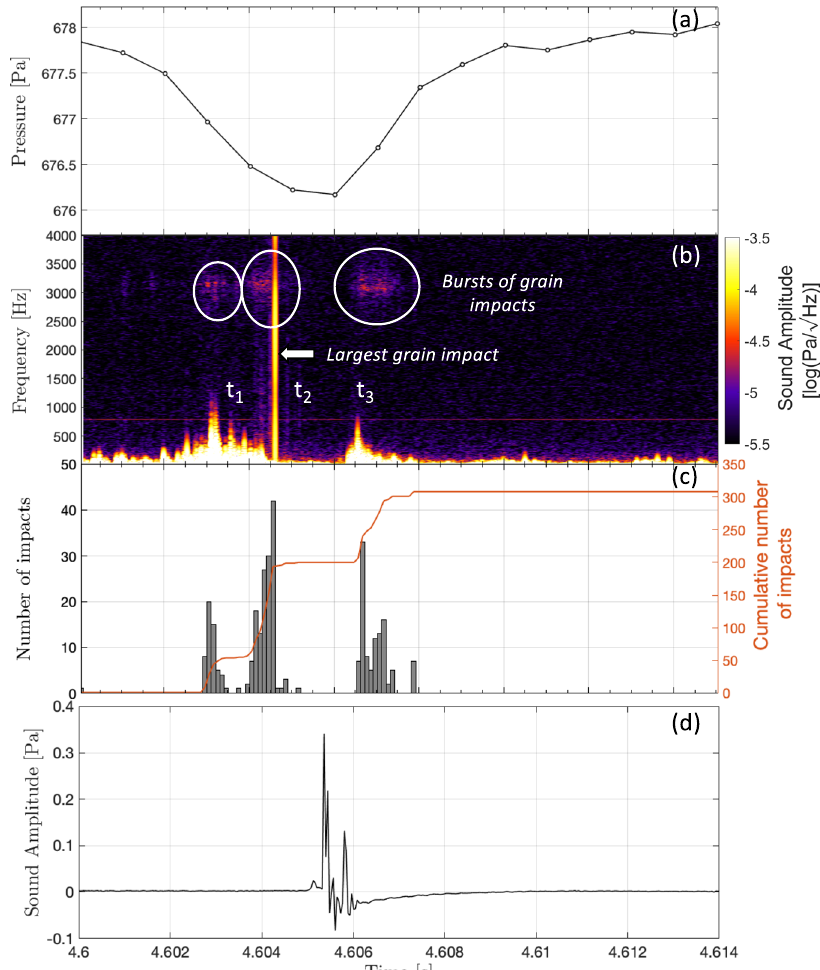
Fig. 5 | Identi fi cation and quanti fi cation of grain impacts. a The pressure data during the dust devil encounter, b the spectrogram of the microphone sound amplitudecalculatedusingawindowsizeof0.2secondsinordertoresolvethe fi ne detailsintheacousticdata, c ahistogram(gray)andcumulativehistogram(orange) of the grain impacts as a function of time and, d the microphone sound amplitude